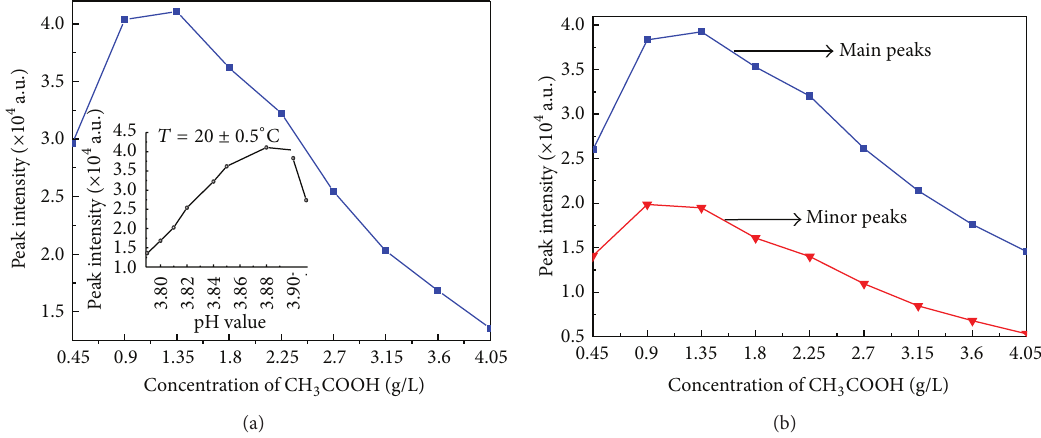
Figure 4: Line chart of polarized fluorescence peak intensities of vinegar-water solutions with different CH 3 COOH concentrations: (a) 0 ∘ and (b) 90 ∘